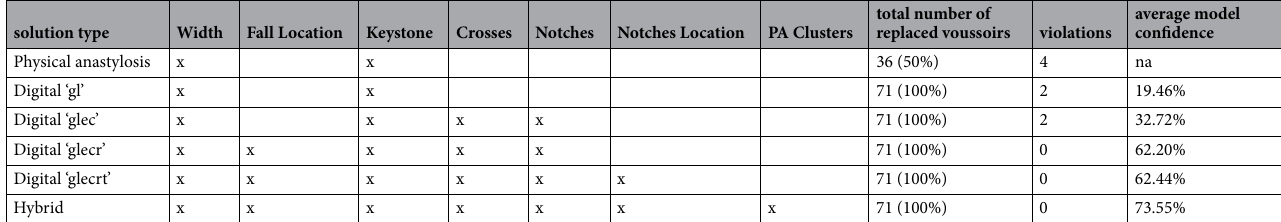
Table 1. Detailing of the milestone models for reconstruction hypothesis with their performance and uncertainty. With gl: gaussian distribution of width; ec: notches and crosses; r: matching fall location with slot location; t: notches locations; hybrid hypothesis: full LP model with pairs from the physical anastylosis